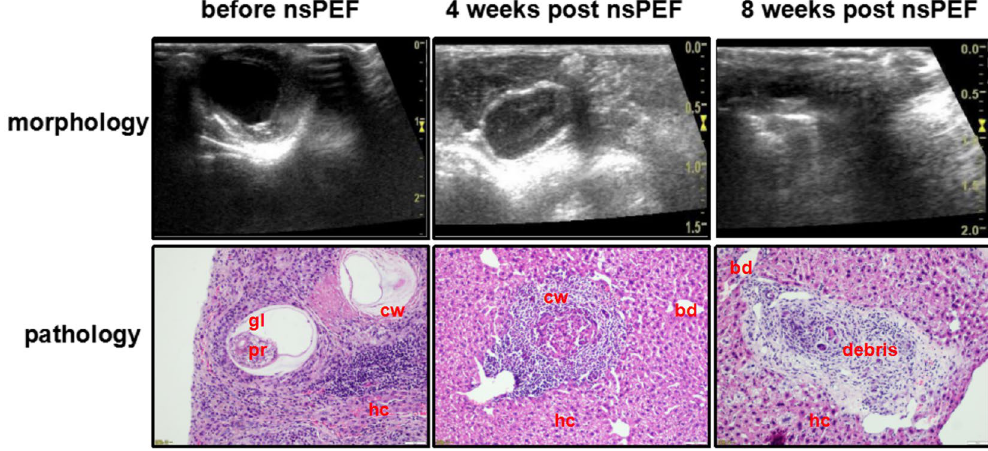
Figure 6. The pathological biopsy and ultrasound follow up after nsPEF. The pathological biopsy and ultrasound follow after nsPEF. The scale bar in ultrasound was present as indicated. The scale bar in pathological slides was 50 μ m. Before treatment, the hydatid cysts showed active germinal layer and protoscolices. The enlarged parasite cysts pressed the hepacytes and congested the portal veins. Four weeks post nsPEF ablation, the ablated hydatid cyst showed focal degeneration without any germinal layers or protoscolices. Eight weeks post nsPEF ablation, mouse liver showed protective immune reactions, such as lymph cell infiltration and fibrosis capsules for the final clean up of the residual